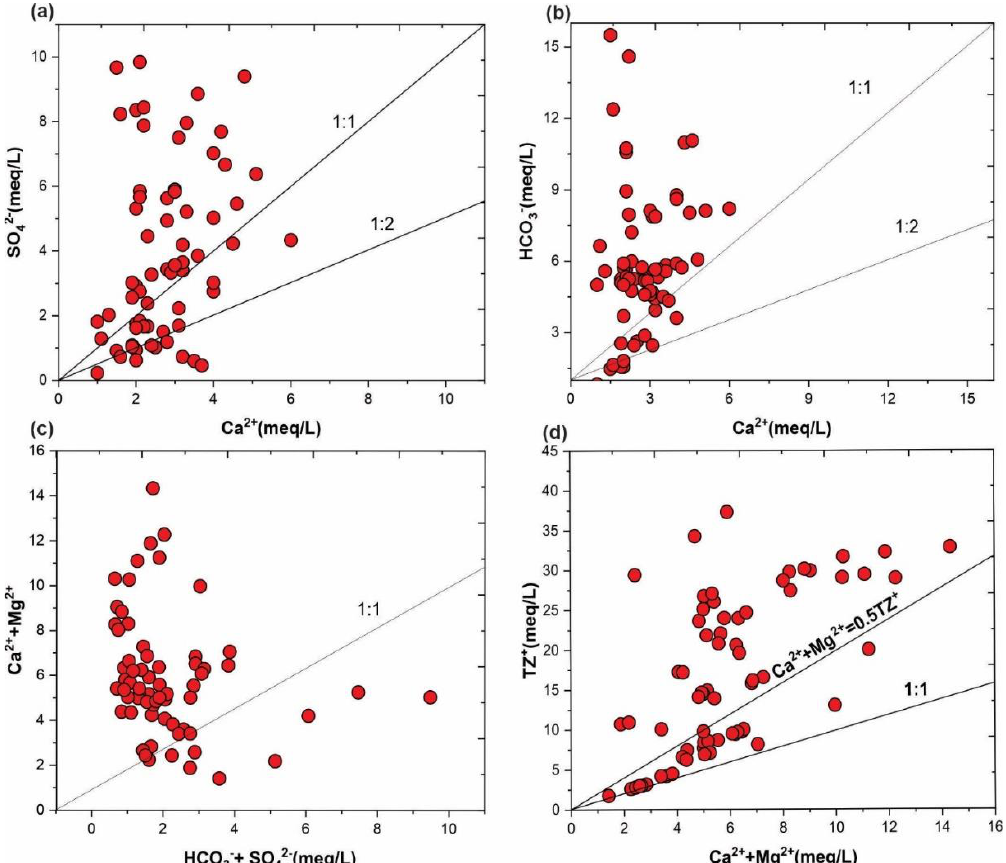
Figure 7. Scatter plot of Ca vs. SO 42 − ( a ), plot of Ca Vs HCO 3 − ( b ), plot of HCO 3 − + SO 42 − vs. Ca + Mg plot ( c ), and scatter plot of Ca + Mg/TZ + ( d ).